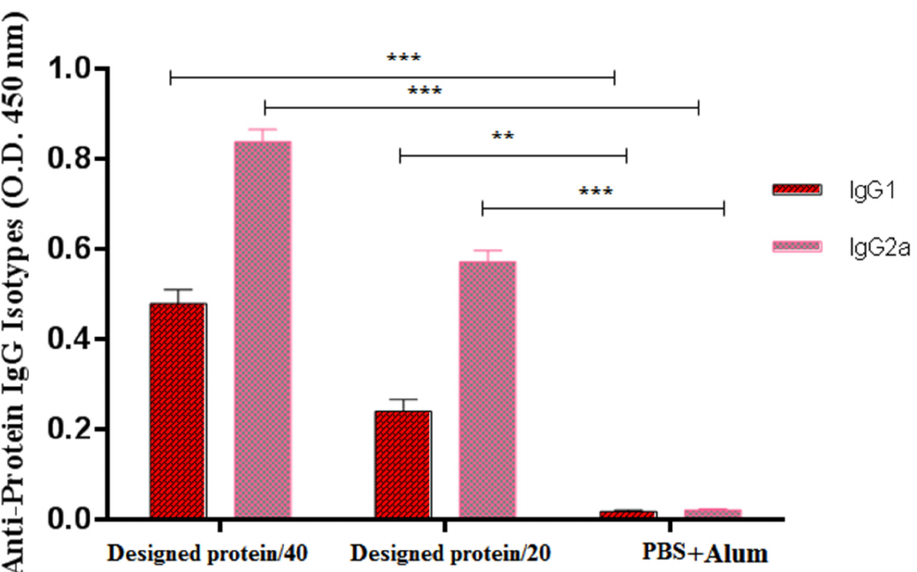
Figure 4. The GPEHT protein with 20 and 40 µg candidates induced high titers of IgG1 and IgG2a. The 40-µg protein candidate induced higher levels of specific IgG1 and IgG2a compared to the 20- µg protein candidate. *** for p < 0.0001; ** for p < 0.001.